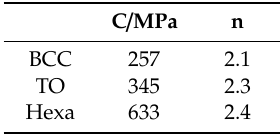
Table 2. Constants for the BCC, TO, and Hexa lattice specimens in the Gibson-Ashby equation.